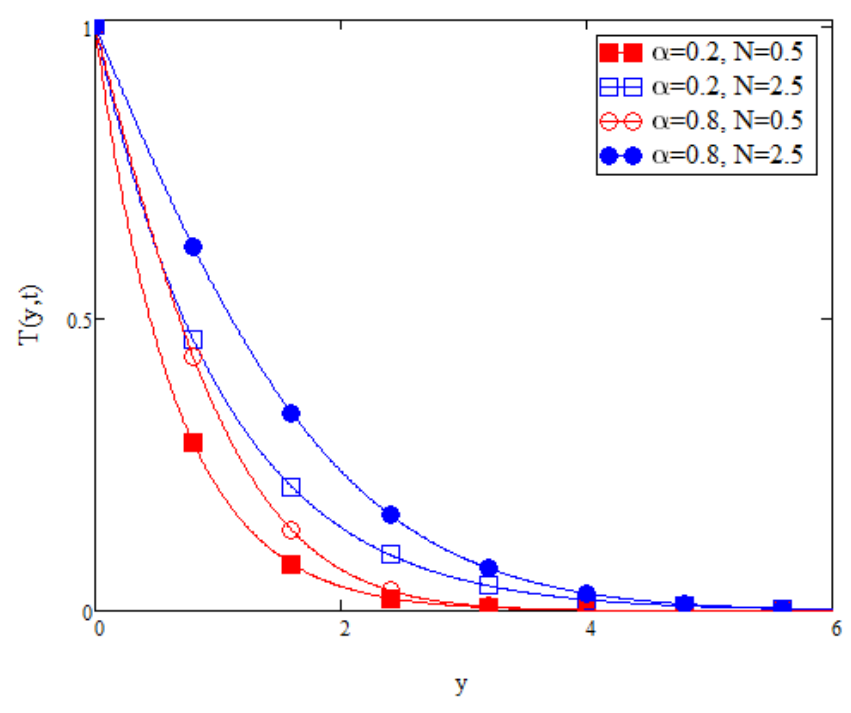
Figure 6. Variation in energy profile due to variations in N and α .